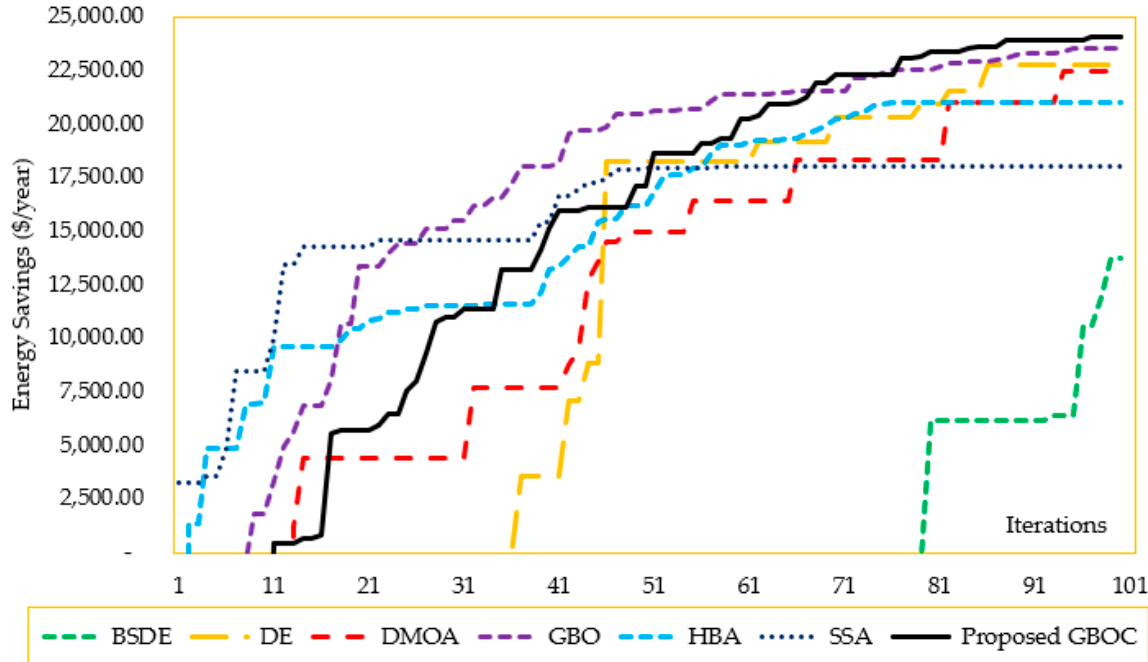
Figure 12. Convergence characteristics of GBOC, GBO, SSA, DMOA, DE, and HBA for the IEEE 69- distribution system for Scenario